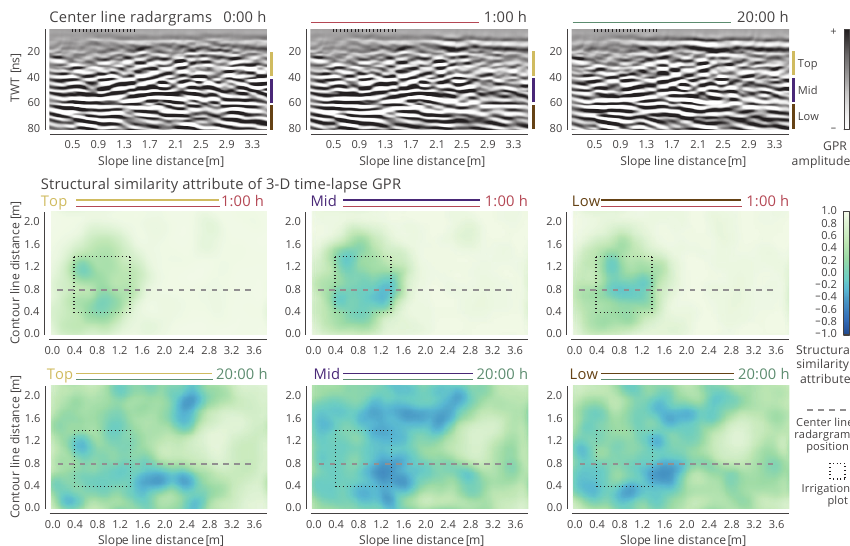
Figure 8. Time-lapse 3-D GPR of irrigation experiment at plot X. Center line radargrams at the marked transect (gray dashed line in lower panels) for the three acquisition times (before 0:00h, directly after irrigation 1:00h, 20:00h after irrigation) are given in the top row. Two way travel time (TWT) is given as original depth reference. The structural similarity attribute of the 3-D data cube is given in three different depth layers (top 20–40ns, mid 40–60ns, low 60–80ns) in the lower panels. The irrigation plot is marked by a black dashed box/line. Slope line distance is increasing downslope.